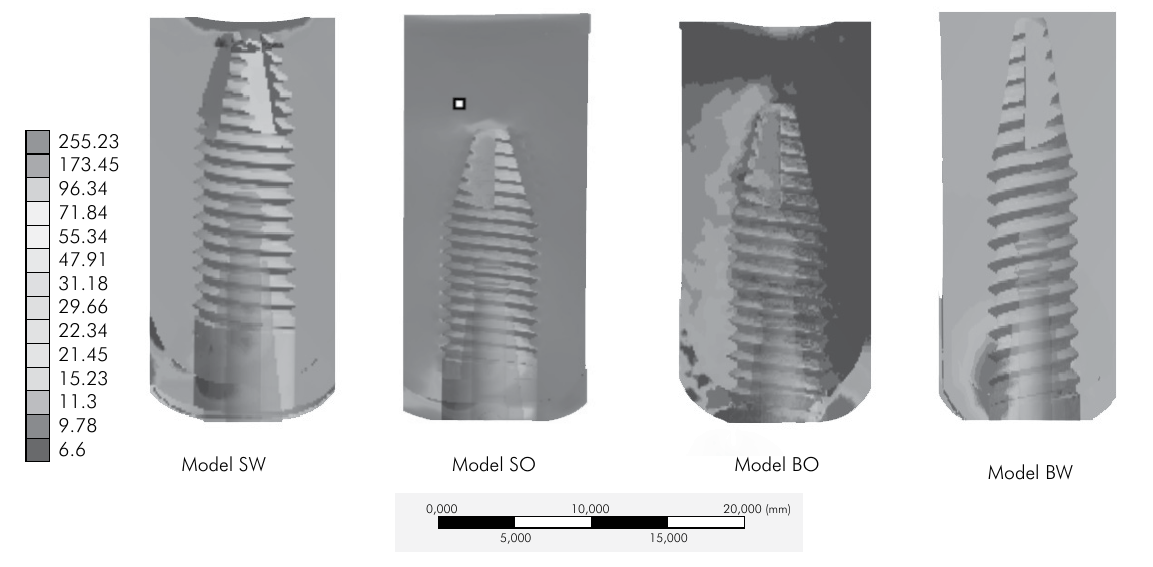
Figure 3. Compressive stress (MPa) around implants with different anchorage designs under eccentric